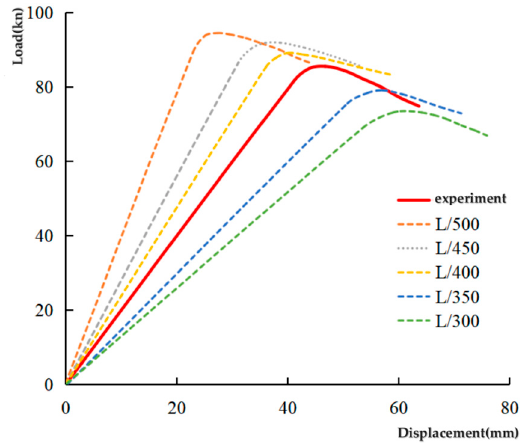
Figure 8. Load-displacement curve of JD-1 under different initial defects.